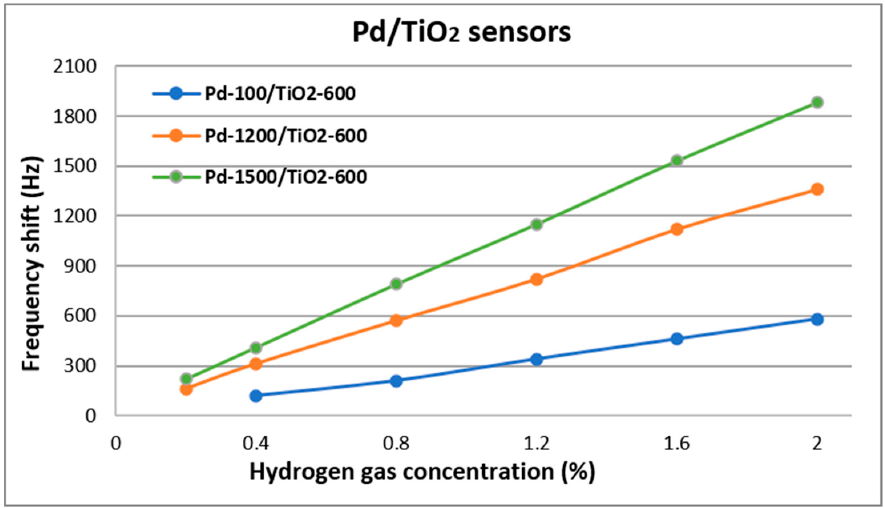
Figure 7. Frequency shift of the Pd/TiO 2 sensors at different hydrogen concentrations.